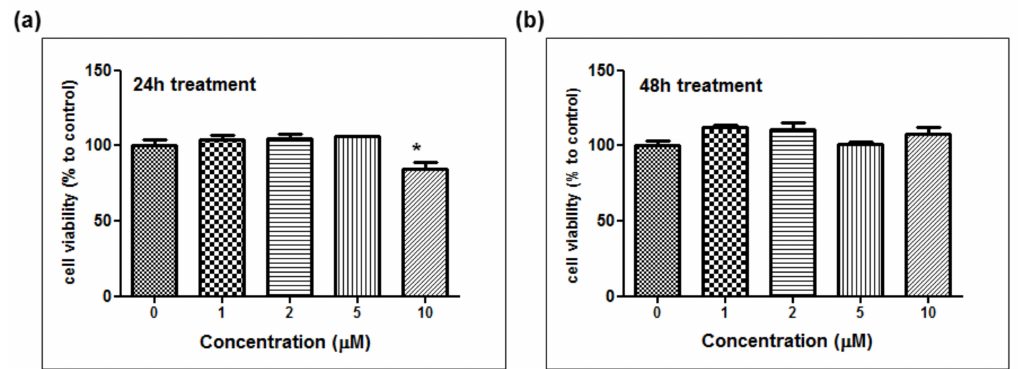
Figure 5. The effect of MHY1498 on the viability of B16F10 melanoma cells. The cells were treated with different concentrations of MHY1498 (0, 1, 2, 5, and 10 µ M) for 24 ( a ) and 48 ( b ) h and assessed for cytotoxicity using an MTT assay. The values represent the mean ± SD for 3 experiments (* p < 0.05, control vs. MHY1498 (10 µ M). The data are expressed as percent compared to the